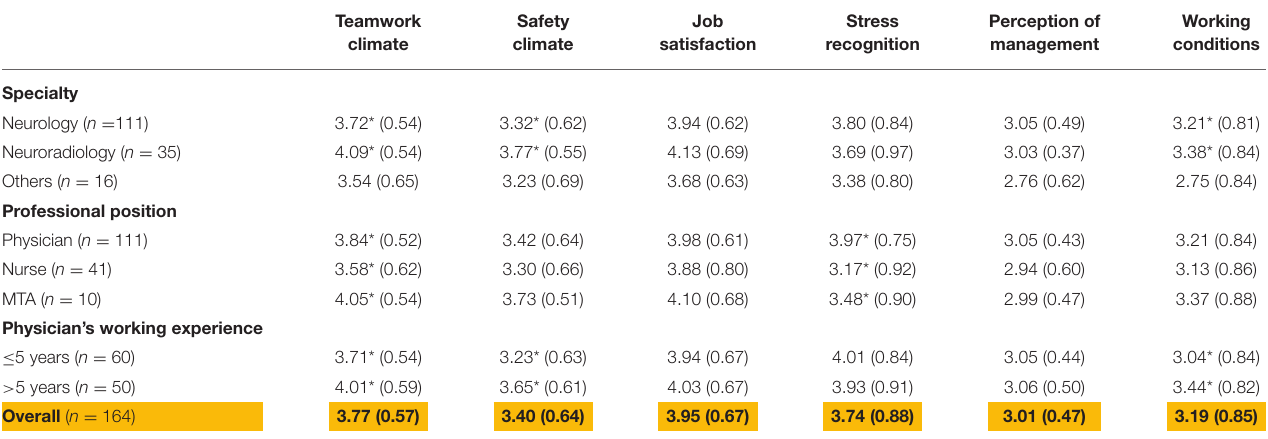
TABLE 4 | Perceptions of patient safety climate per specialty, professional position and working